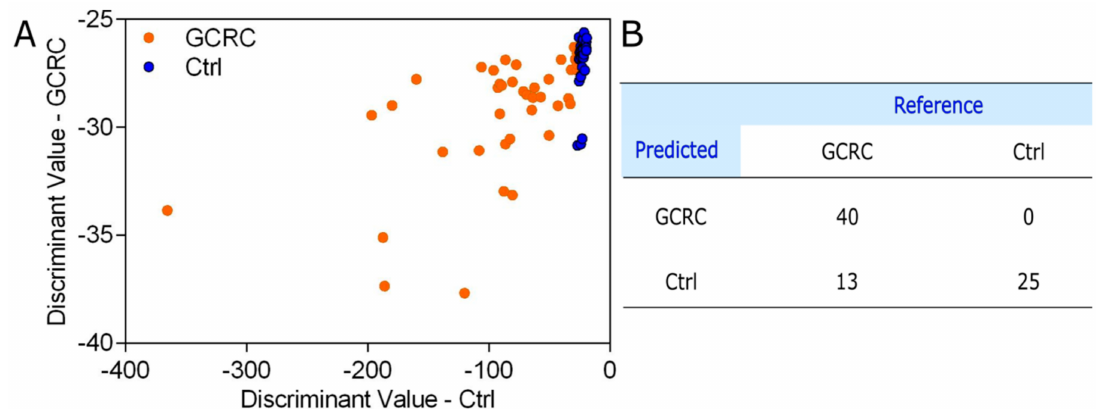
Figure 6. PCA-QDA based on SERS spectra of serum and blood tests. ( A ) The prediction plot of the PCA-QDA model combining CRP levels, hemoglobin levels, neutrophil counts and platelet counts with the SERS profiling of serum (1300 wavenumbers for each sample) from 53 patients with gastric and colorectal cancer (GCRC) and 25 control subjects (Ctrl), using the first seven principal components as input. ( B ) The confusion matrix yielded by the PCA-QDA on SERS spectra of serum and blood